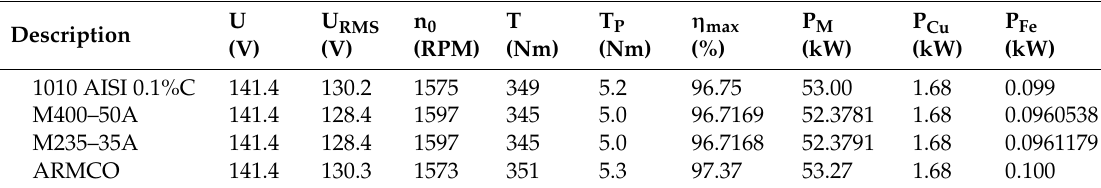
Table 9. Impact of using various ferromagnetic materials to build the rotor on the obtained ERPMSM parameters.